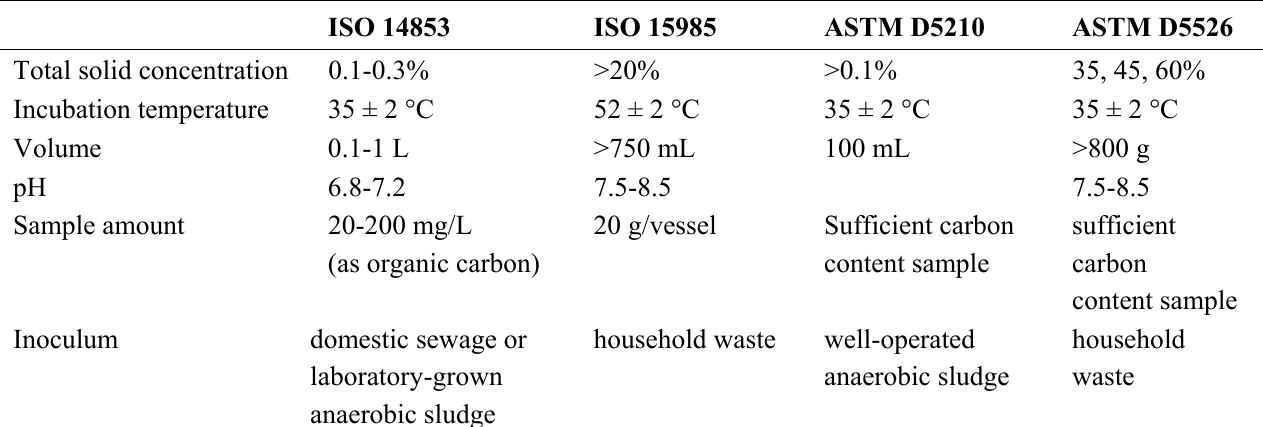
Table 1. Anaerobic biodegradation evaluation methods based on International Standards. ISO 14853 ISO